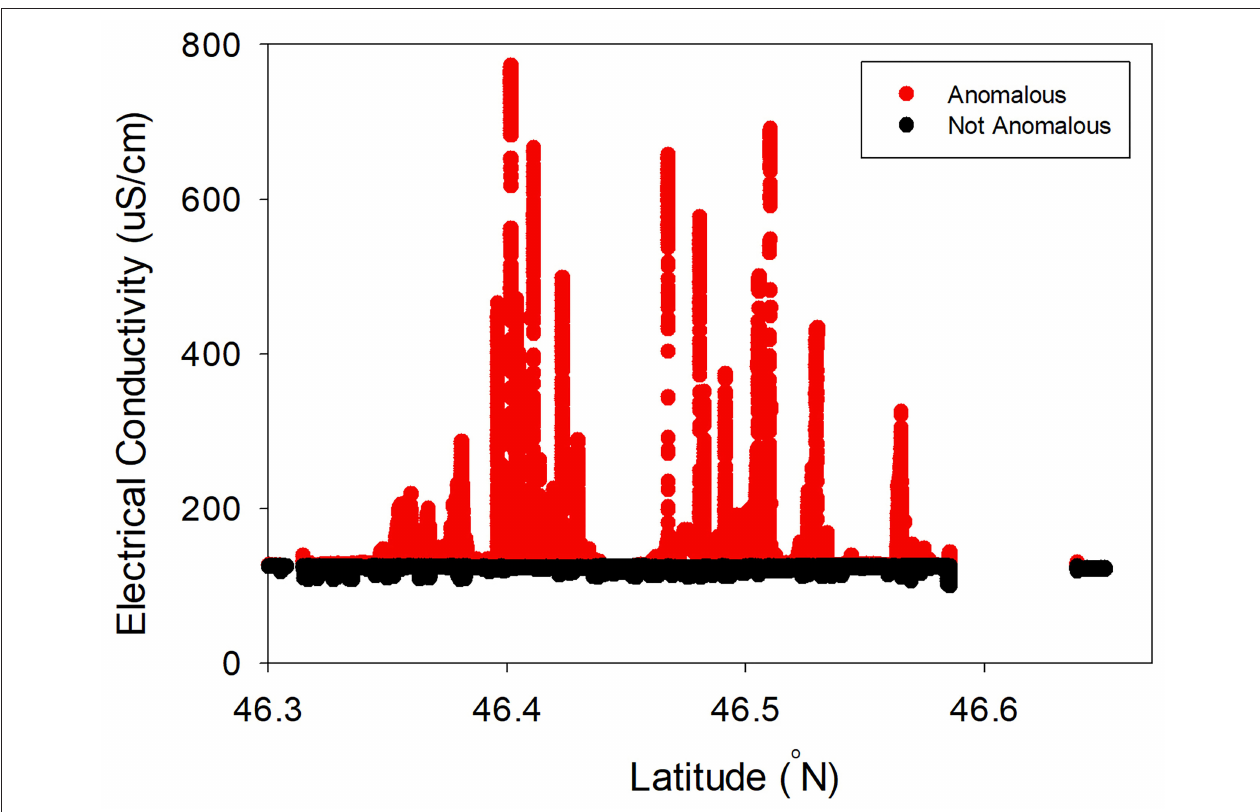
FIGURE 6 | Example of EC anomalies determined from EC values measured during the summer, plotted in space (North to South along the river). Values below the median indicate values similar to river water (Categories 3 and 4), while those above the median indicate comparatively more saline inflows (Categories 1 and 2).